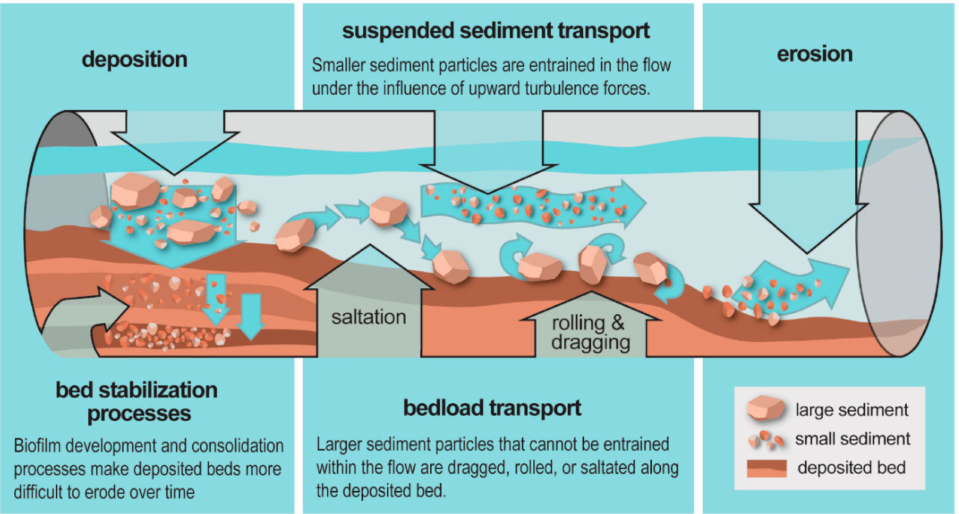
Figure 1. Illustration of sewer sediment settling, erosion, and transport processes in gravity sewers along with their deposited bed interactions. Descriptions for suspended sediment transport, bedload transport, and bed stabilization processes based on Butler and Davies [13], Butler et al. [10], and Ashley et al. [2],